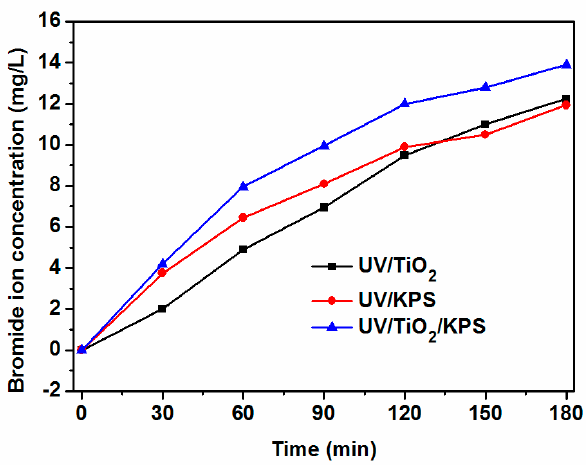
Figure 4. The change of bromide ion in water samples from different time points (the initial concentration of HBCD is 25.0 mg/L, KPS dosage is 4 mg/L, and TiO 2 dosage is 100 mg/L).